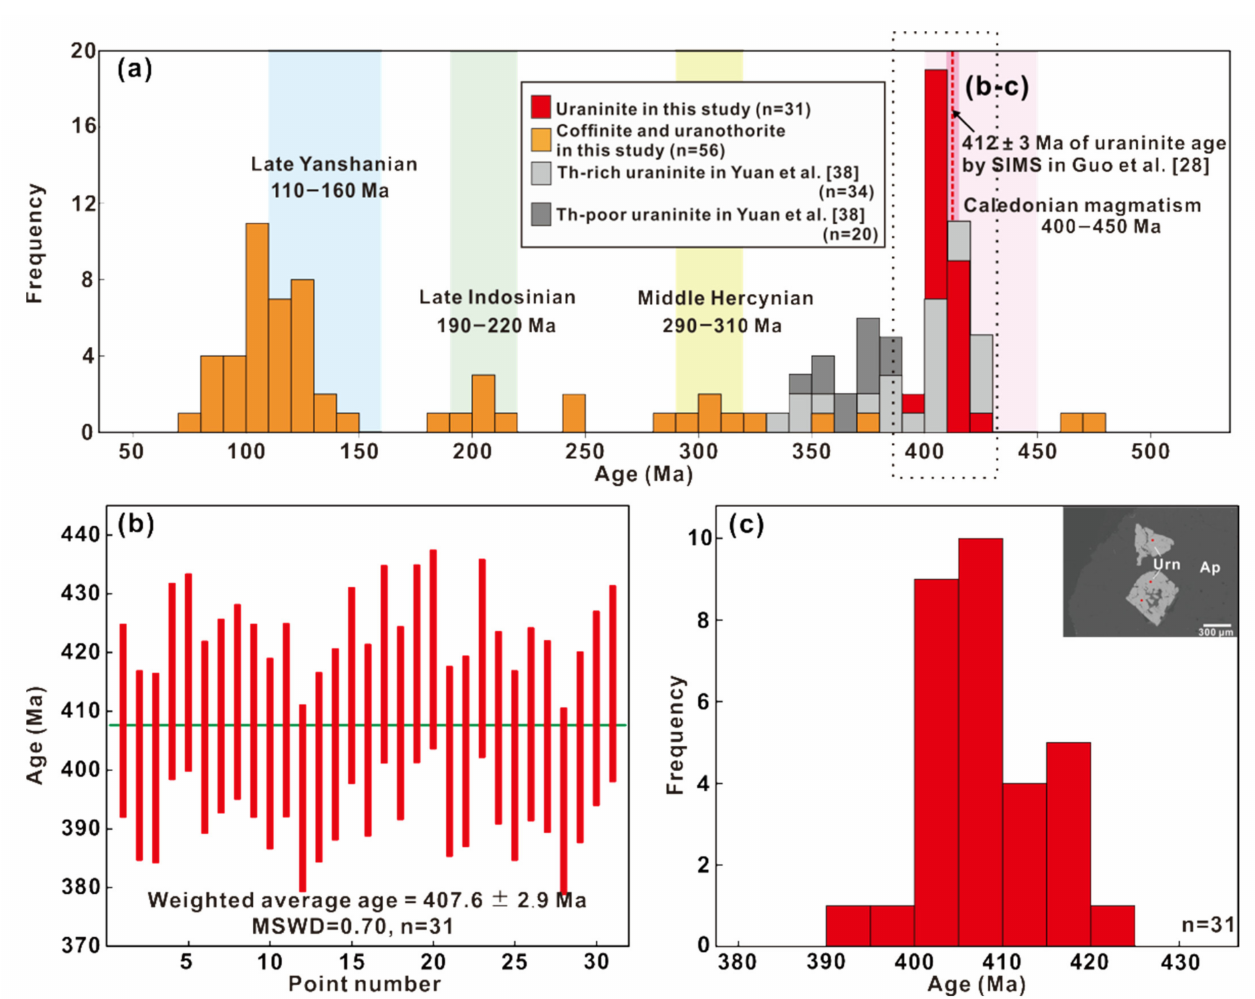
Figure 10. ( a ) Histogram showing U-Th-Pb age variations of uraninite, coffinite and uranothorite from the Guangshigou deposit, data from Guo et al. [28] and Yuan et al. [38] are selected for comparison. ( b , c ) U-Th-Pb age variations of uraninite and their weighted average value plotted on Isoplot chart ( b ) and histogram ( c ) based on 31 measurements on uraninite from the Guangshigou deposit. Abbreviations: Ap—apatite,